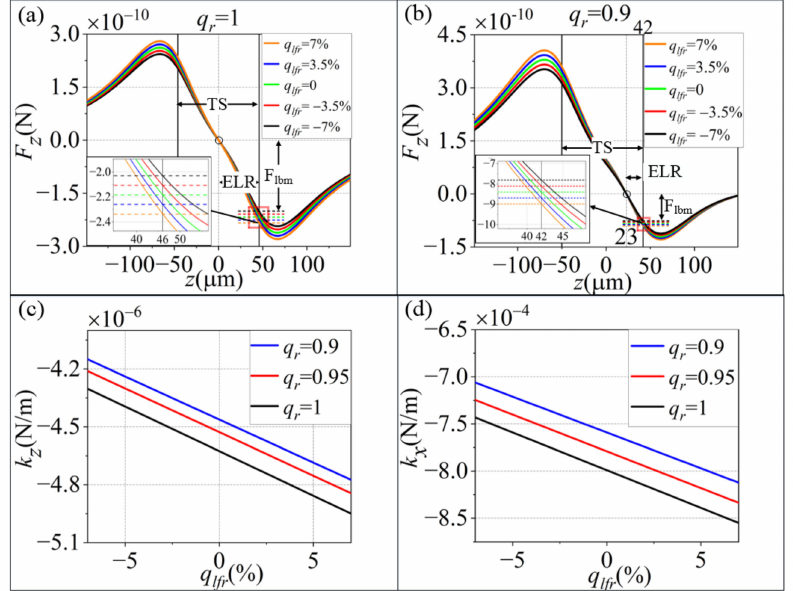
Figure 3. The optical force and stiffness fluctuation with the laser intensity fluctuation at different fixed q r values. ( a ) q r = 1 and ( b ) q r = 0.9 along the Z -axis; ( c , d ) are the relationships of laser intensity fluctuation and stiffness at different fixed q r values along the Z and X axes, respectively. Here, laser intensity P ( t ) = ∆ P ( t ) + P , where P denotes the mean intensity, q lfr is the synchronous intensity change rate, and q lfr = ∆ P / P